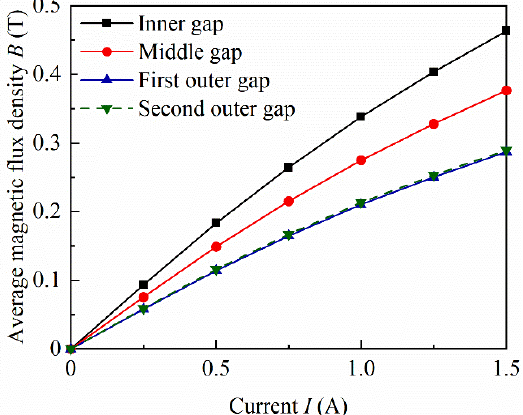
Figure 6. Average magnetic flux density of the initial MR damper along the detected damping gap with various current inputs [31].